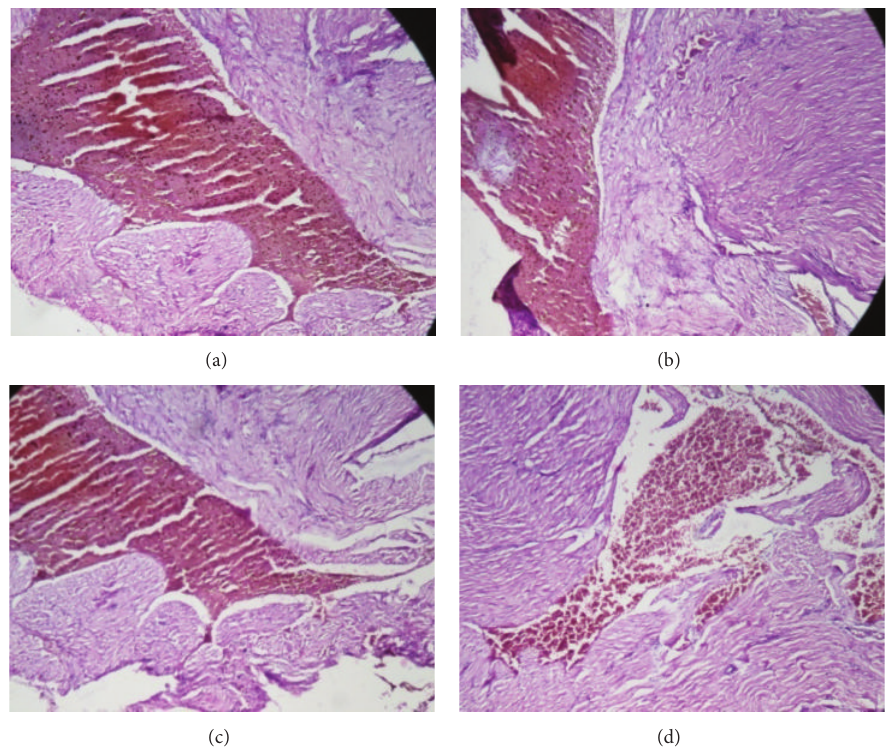
Figure 3: Histology of heart (H&E, 100x) of control and OSE-treated animals. (a) Section of heart from control animal showed normal muscle fibers with acidophilic cytoplasm and centrally located nuclei; ((b), (c), and (d)) heart from OSE (200, 400, and 800 mg/kg)-treated animals exhibit normal muscle fibers with acidophilic cytoplasm and centrally located